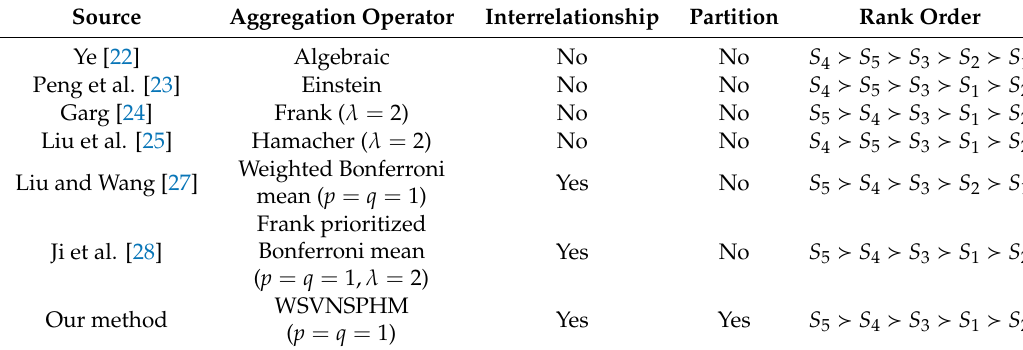
Table 5. Comparison